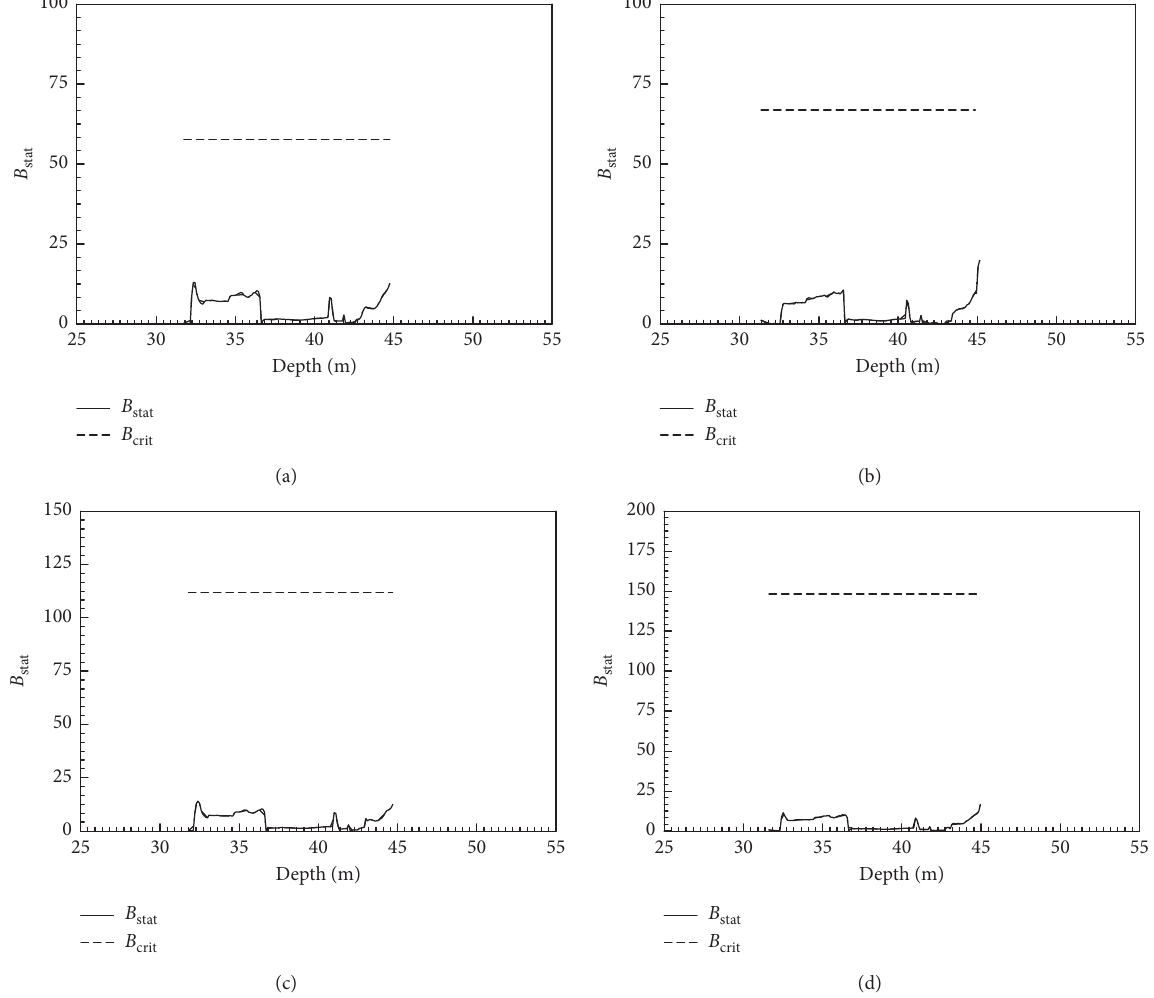
Figure 10: Validation of stationarity of r for the medium silty clay layer. (a) M